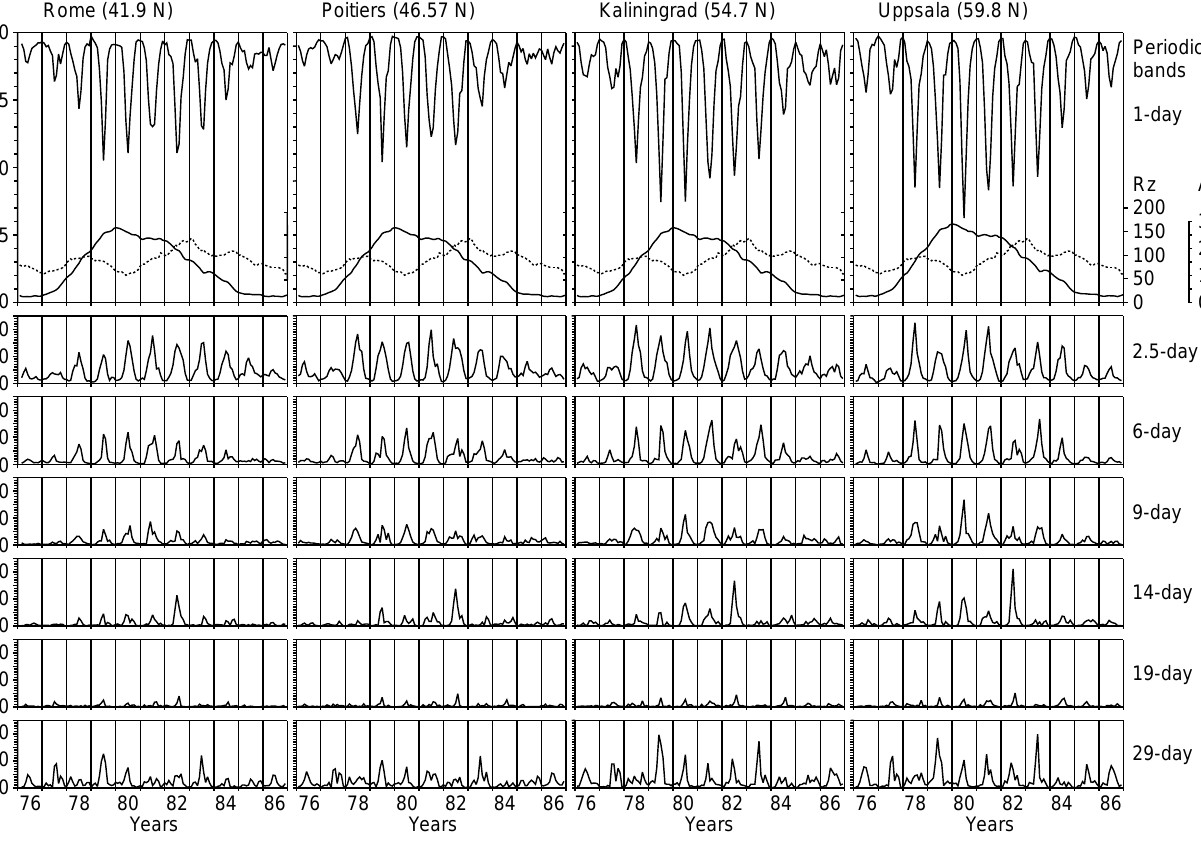
Fig. 4. Annual and solar cycle variations of the integrated percent contributions for daily variation and for 2.5, 6, 9, 14, 19 and 29-day periodic bands. The 12-month smoothed averages of monthly means